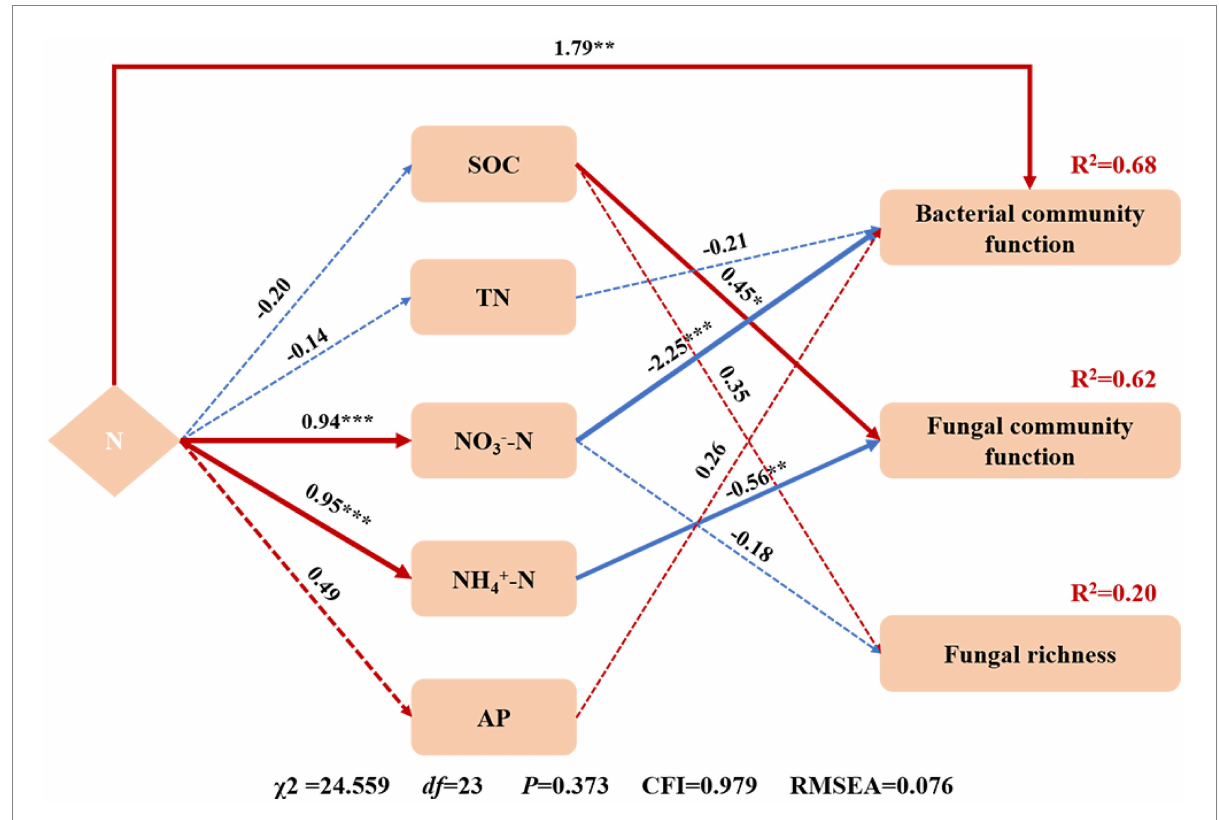
FIGURE 7 Structural equation model (SEM) of the effects of N addition on soil properties (SOC, TN, NO 3 − -N, NH 4+ -N, and AP) and microbial community richness and function. Arrows indicate the hypothesized direction of causation. The numbers next to the arrows are standardized path coefficients. The width of the arrows represents the strength of the relationships. Red arrows represent positive and blue arrows represent negative relationships. The solid arrows represent significant, and the dashed arrows represent non-significant relationships. To improve the adaptability of the model, delete the paths with less correlation. * Indicates p < 0.05, ** indicates p < 0.01, *** indicates p <